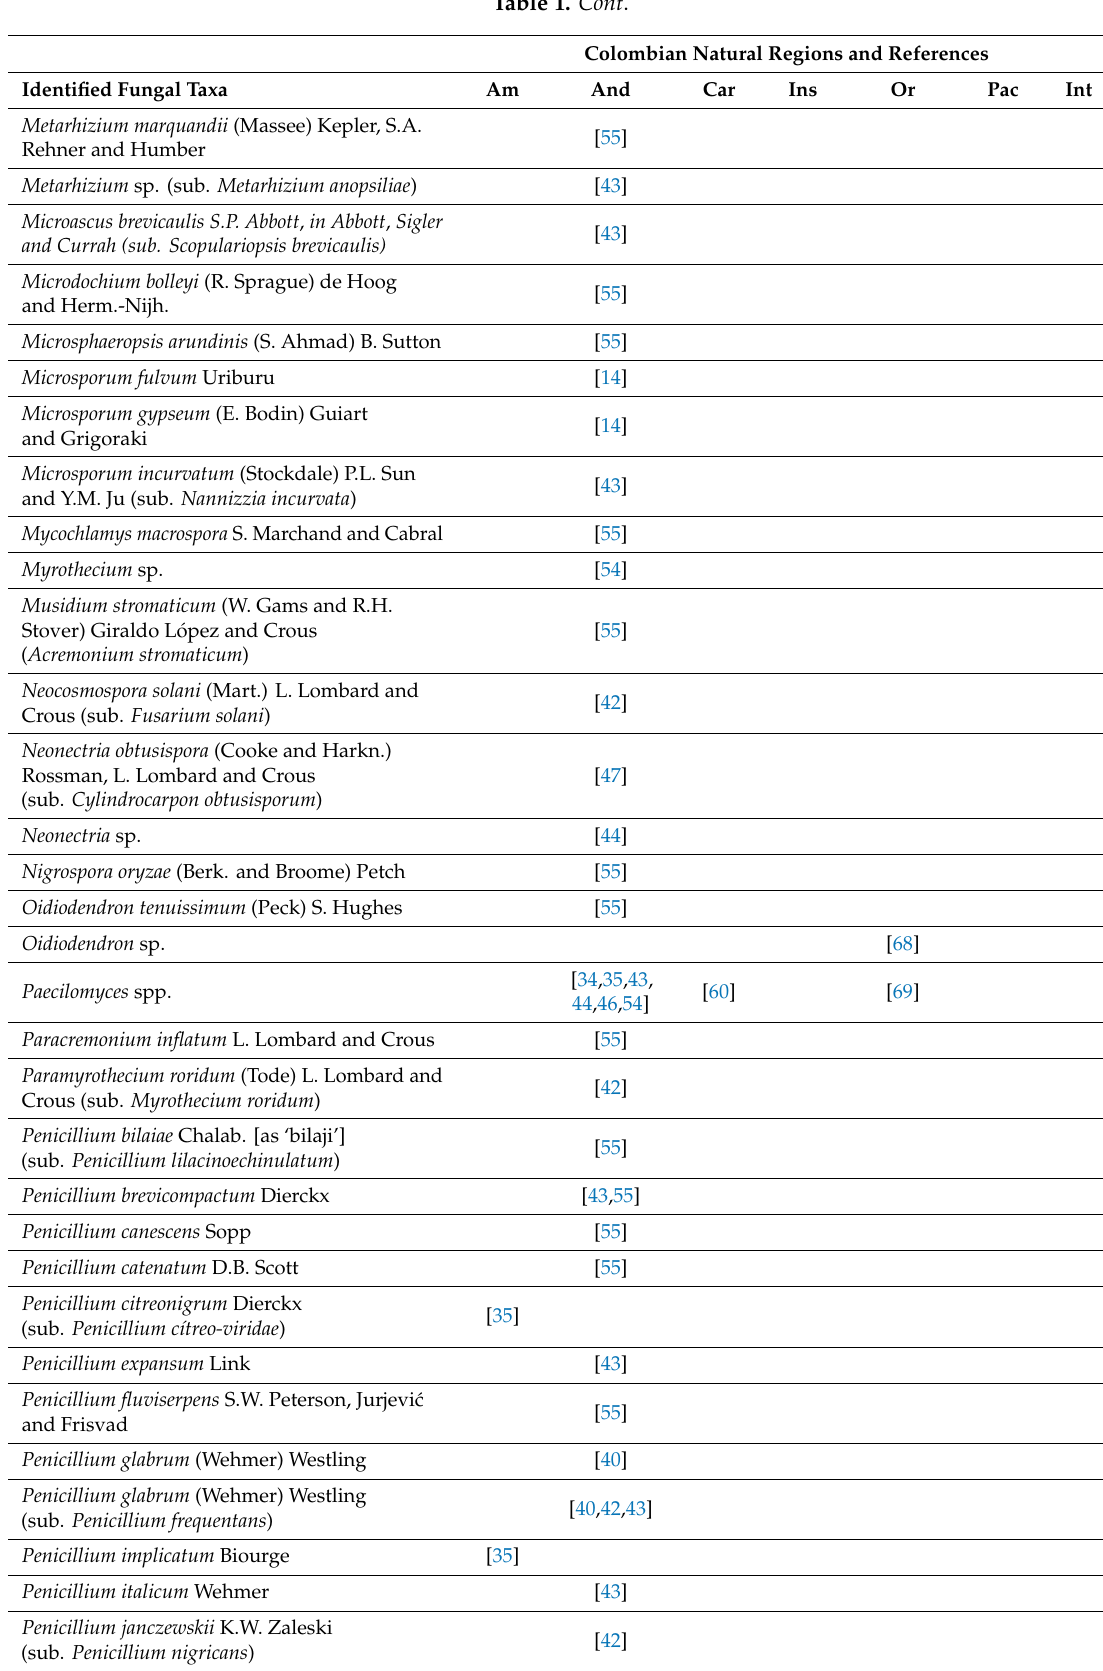
Table 1. Cont . Colombian Natural Regions and